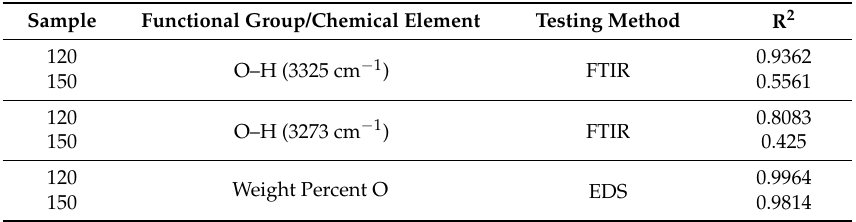
Table 6. Correlation between DP and functional group/chemical element of transformer insulation